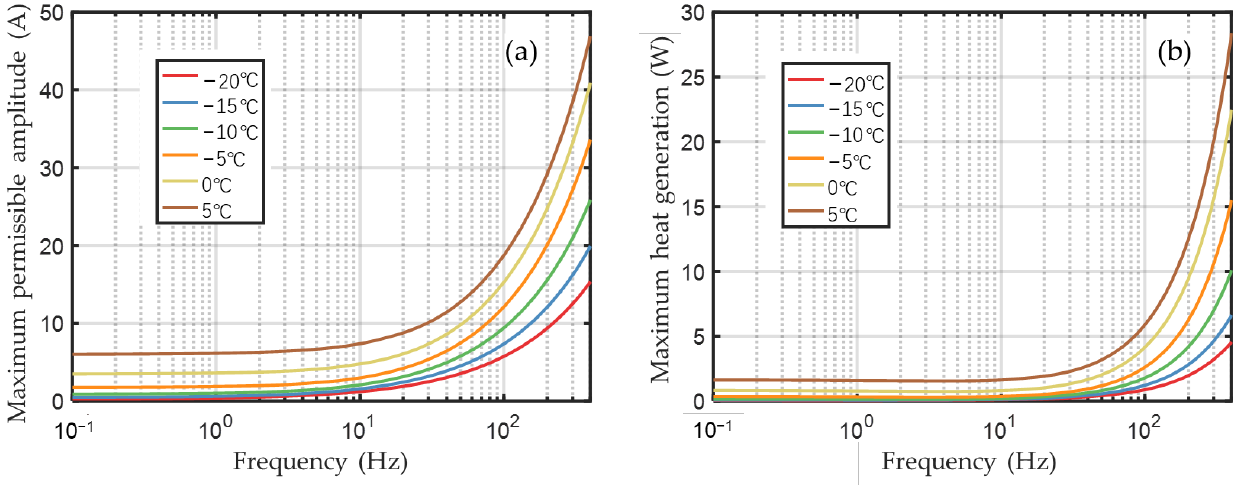
Figure 6. ( a ) Operation boundaries of lithium plating prevention in terms of maximum current amplitudes at different frequencies and different temperatures; ( b ) maximum heat generation rate at different frequencies and different temperatures.